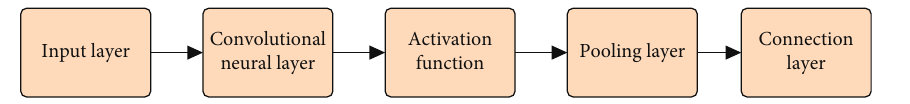
Figure 2: Convolutional neural network algorithm.